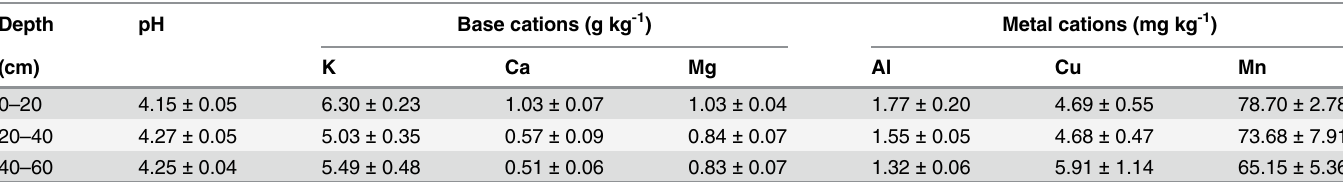
Table 1. The total concentrations of mineral elements in the initial